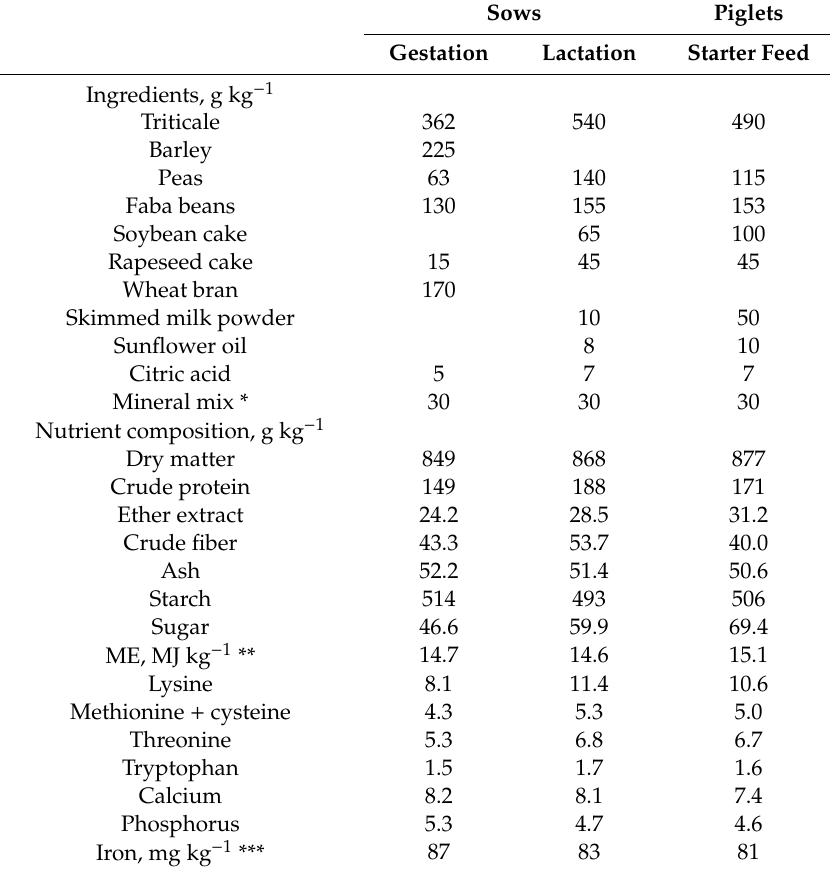
Table 1. Ingredients and nutrient composition of diets for piglets receiving di ff erent frequencies of iron supplementation, and their mother sows. One bulk sample of each feed mixture was analyzed, and values are given on a dry matter basis. Sows Piglets Gestation Lactation Starter Feed Ingredients, g kg − 1